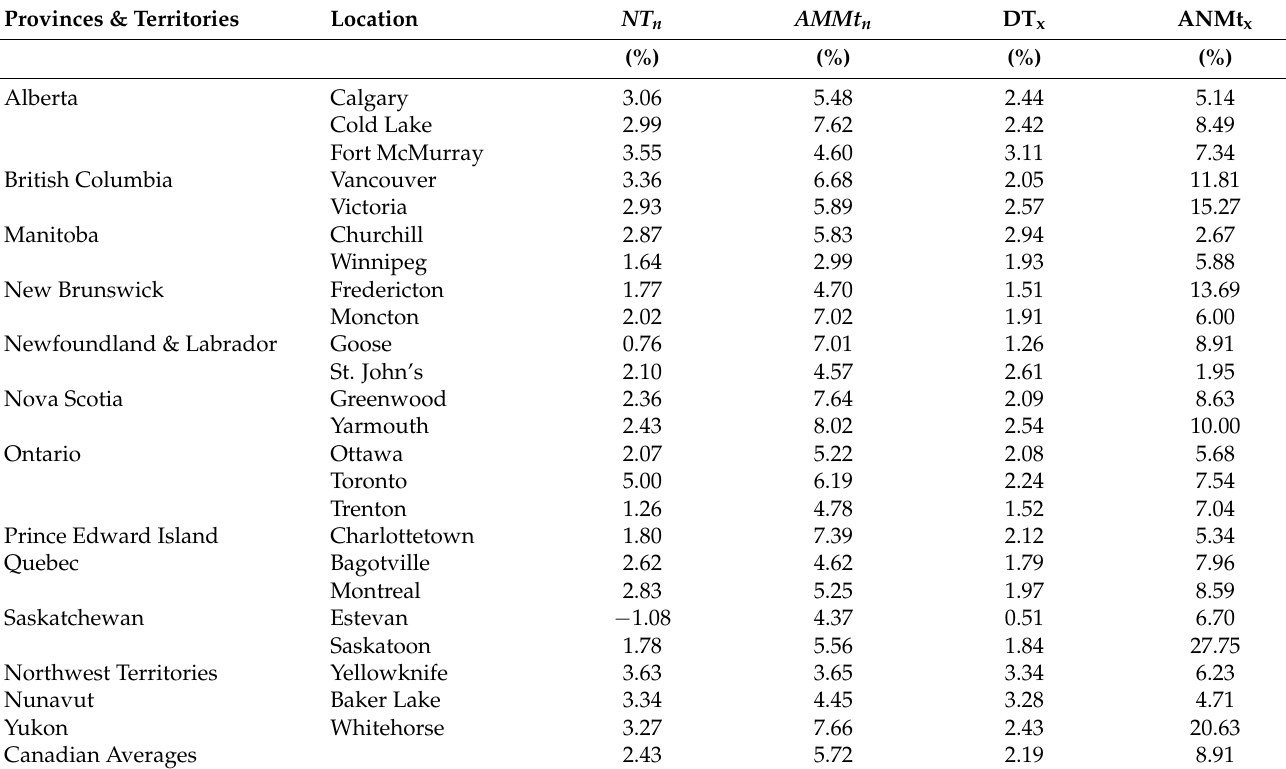
Table 6. Climate parameter sensitivity indices for diurnal temperature and timing